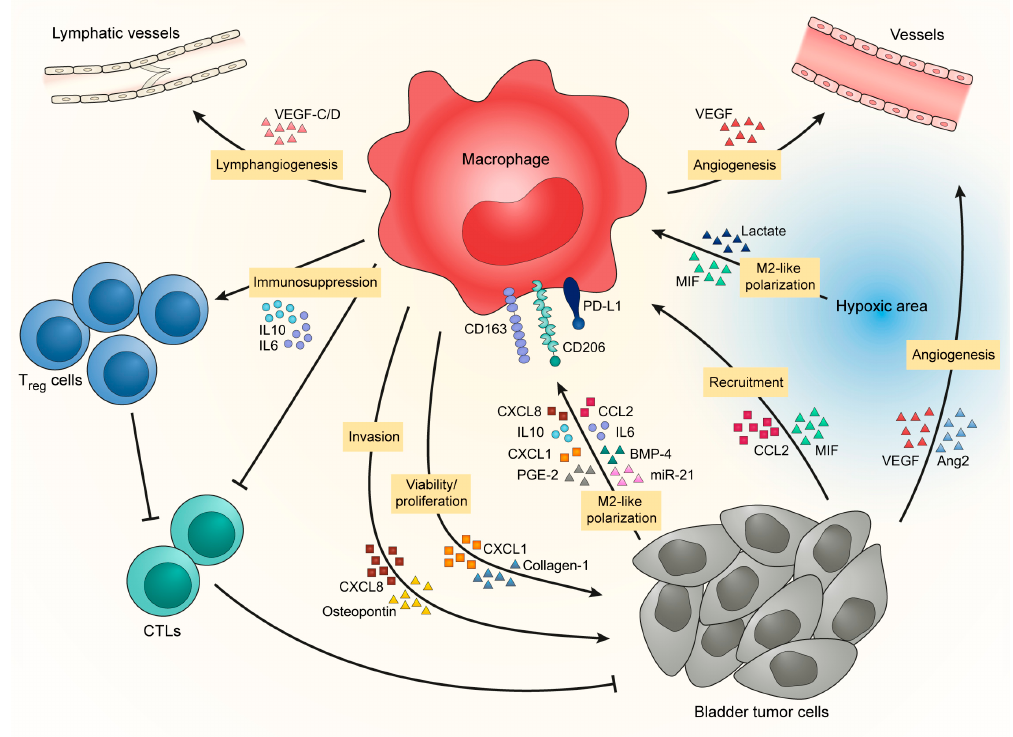
Figure 1. BCa favors M2-like polarization of TAM to promote tumor progression.